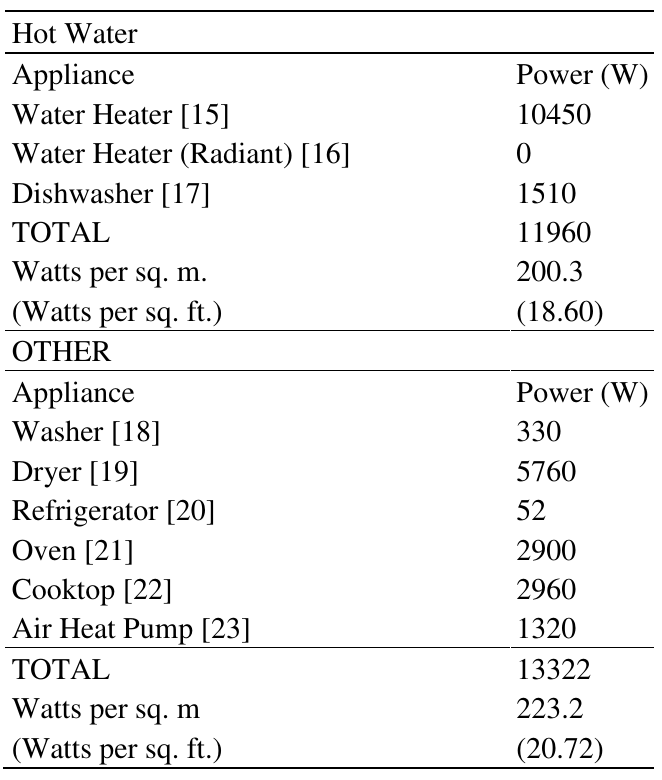
Table 1. The various appliances and wattages used in Team Missouri’s solar house entry during 2009 Solar